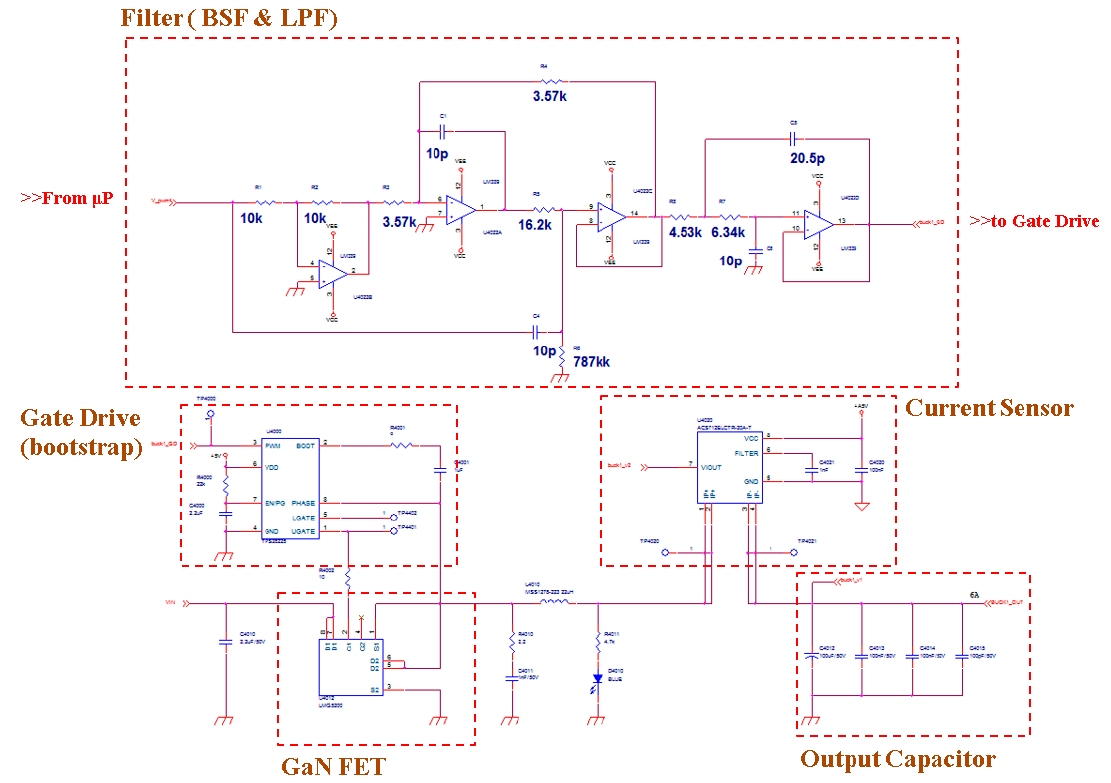
Figure 11. The proposed filter circuit and the power conversion topology with GaN FET. (Second order band-stop and low-pass filters).